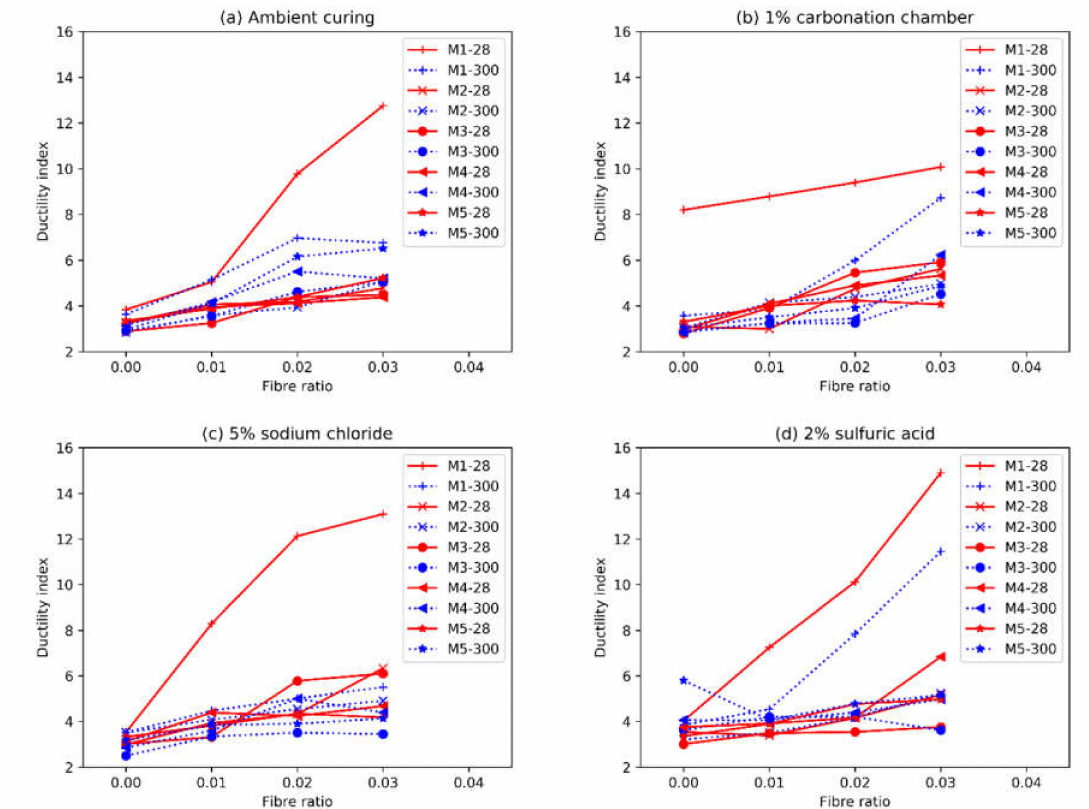
Figure 8. The ductility indices of the specimens at 28 and 300 days in ( a ) ambient curing room,